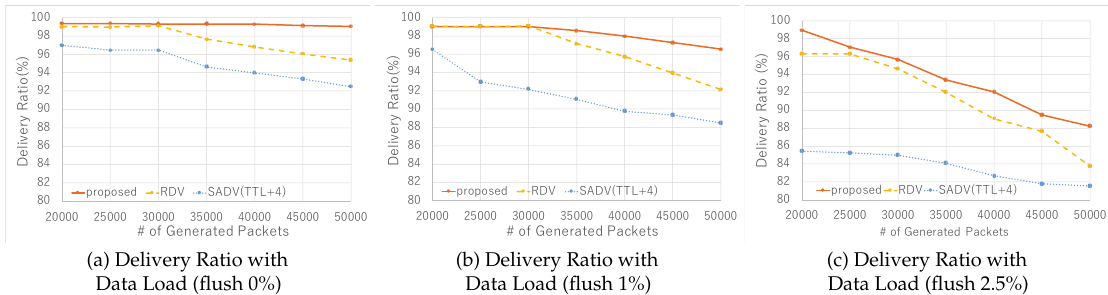
Figure 12. Delivery ratio with various data loads: delivery ratio under variation of data load is shown for each flush rate 0%,1%, and 2.5%.